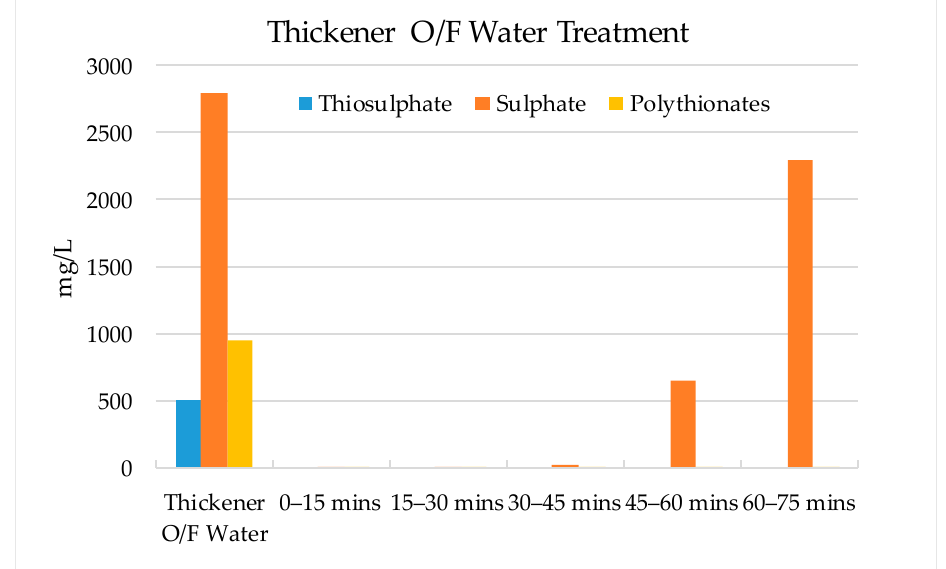
Figure 15. Concentration of residual anions at adsorption stages of Process Water. Minerals 2020 , 10 , x FOR PEER REVIEW